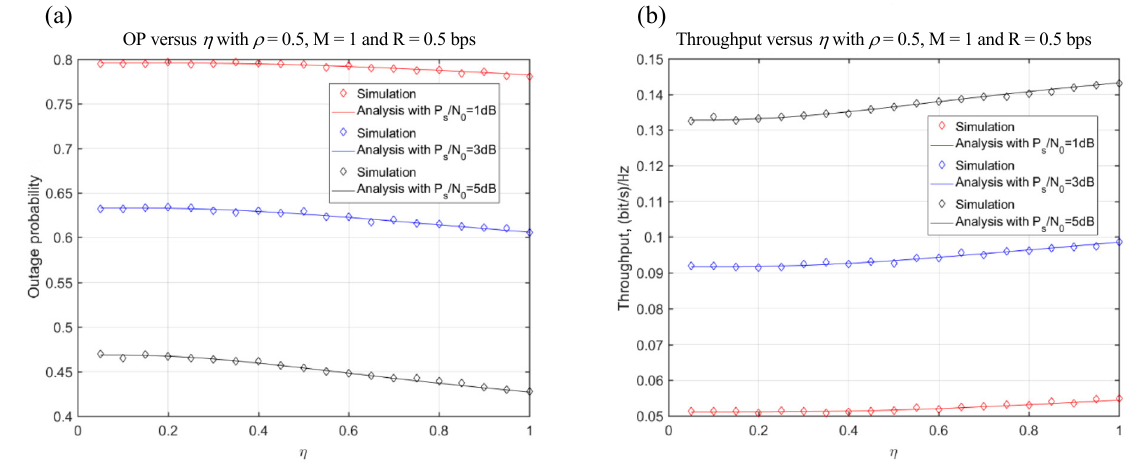
Fig. 4. Outage probability (a) and achievable throughput (b) versus the energy harvesting efficiency η .